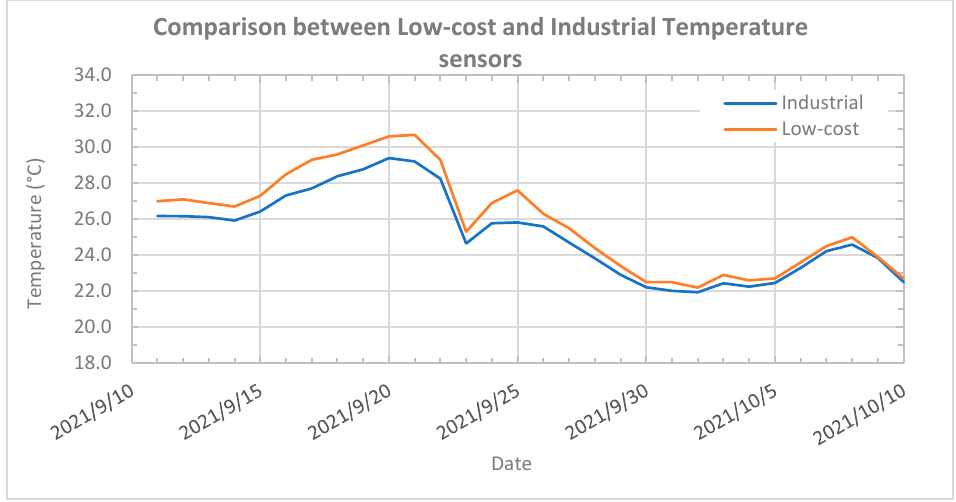
Figure 5. Comparison of industrial and low ‐ cost temperature sensors’ measurements.